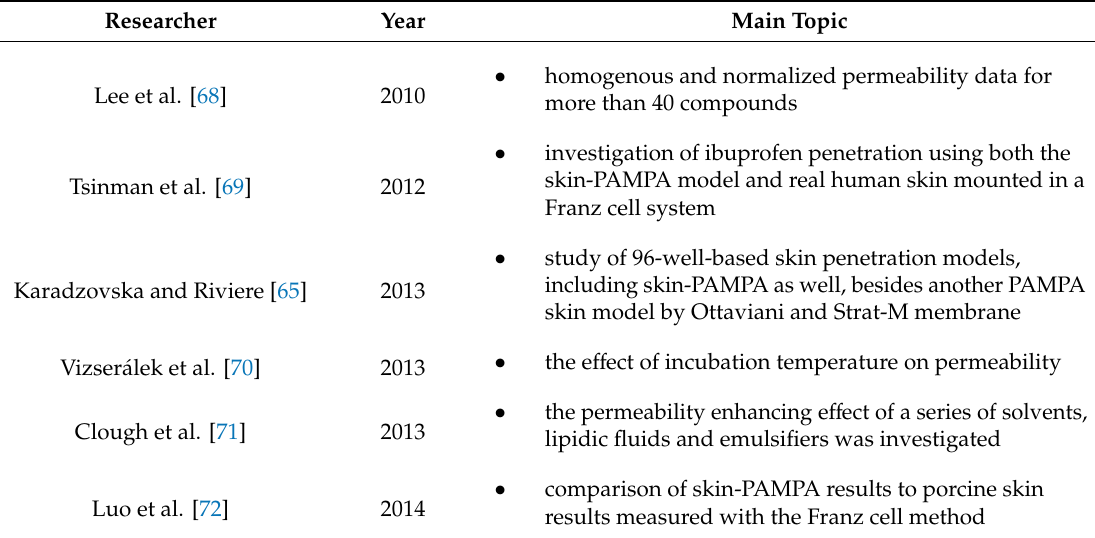
Figure 8. Experimental design of the skin-PAMPA method. Table 3. Posters and articles related to the skin-PAMPA method [67].